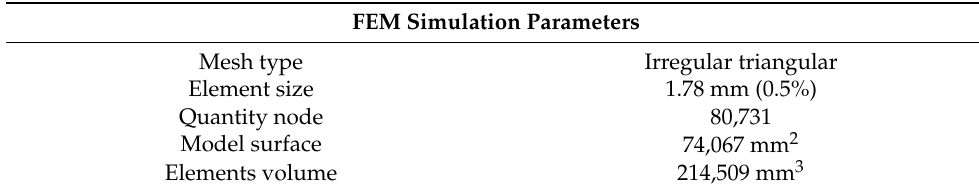
Table 3. FEM simulation parameters of MIM process.